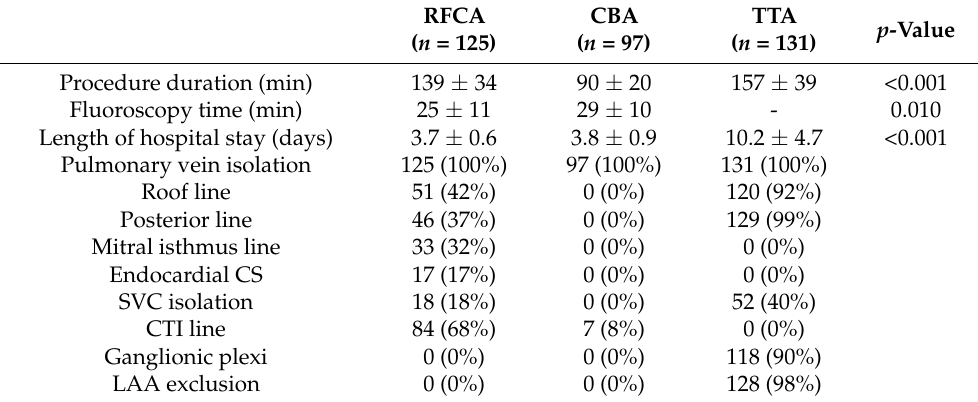
Table 2. Procedural